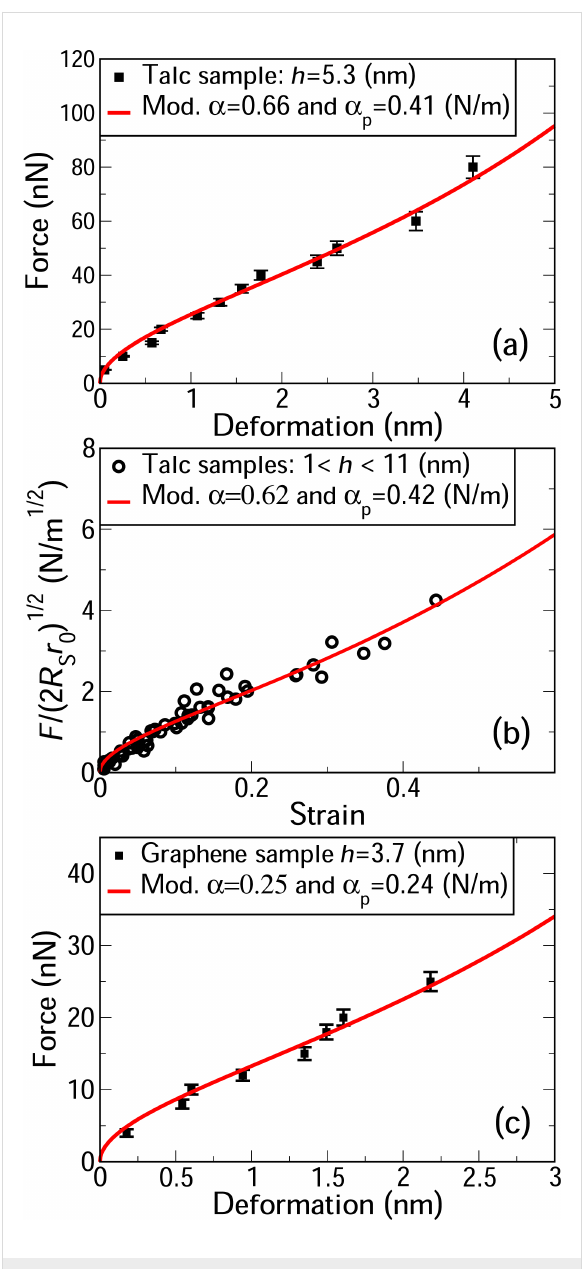
Figure 4: (a) Best fit of Equation 3 to forces and deformations measured using AFM on a 5.3 nm thick talc fold. (b) Best fit of Equa- tion 3 to forces and deformations in folded edges of several talc flakes, with thicknesses of 1.2, 2.9, 5.3, 6.7, 7.4, and 10.9 nm. The vertical axis is the rescaled force, and the horizontal axis is the strain S = D /(2 R 0 − d ) (see Supporting Information File 1). (c) Best fit of Equation 3 to AFM measurements on a fold in an eleven layers thick graphene